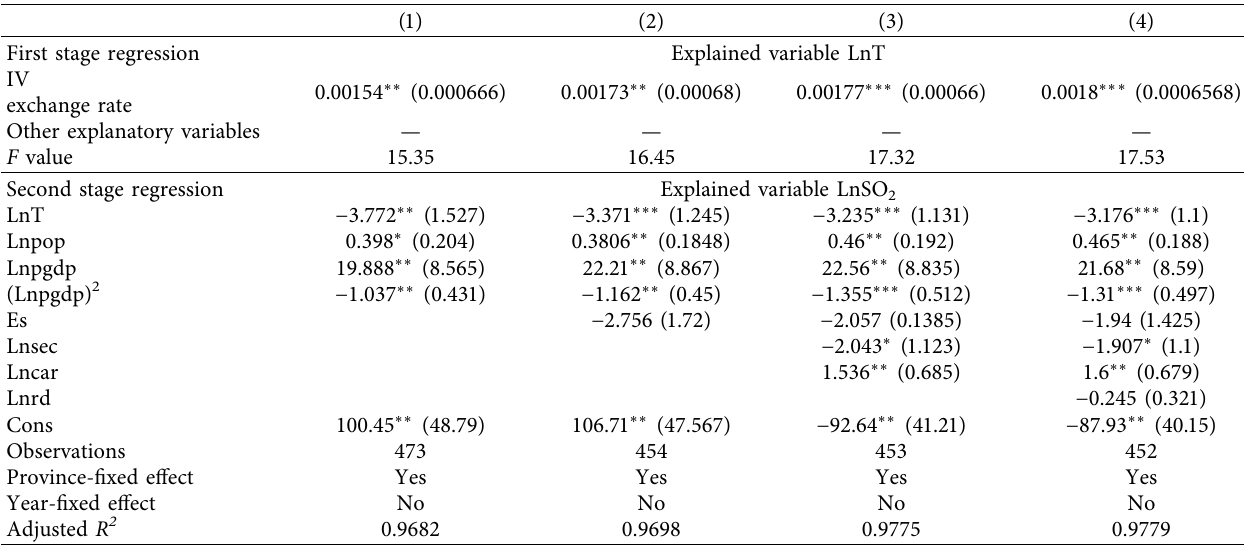
Table 5: Robustness test of changing the explained variable.